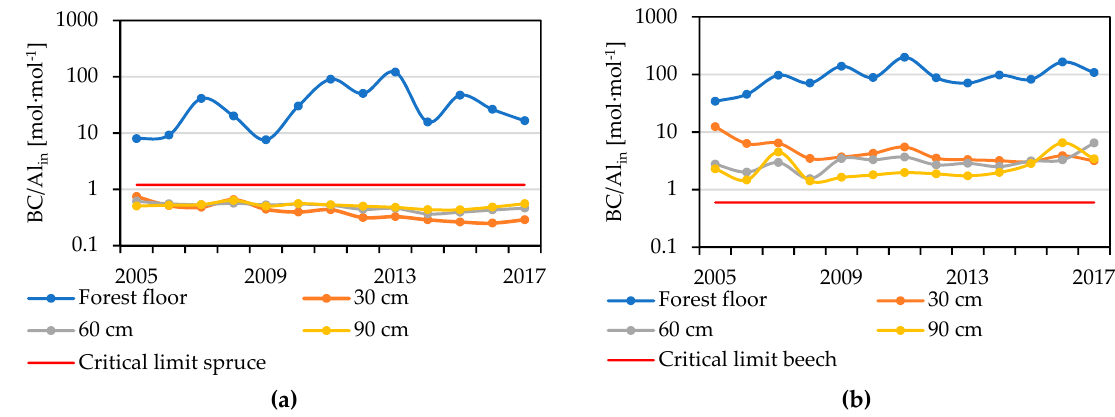
Figure 7. Annual molar Bc/Al in ratios in the soil solution below the forest floor and at 30 cm, 60 cm and 90 cm of the mineral soil in the spruce ( a ) and the beech ( b ) stand. Critical limits are presented according to Sverdrup and Warfvinge [32].